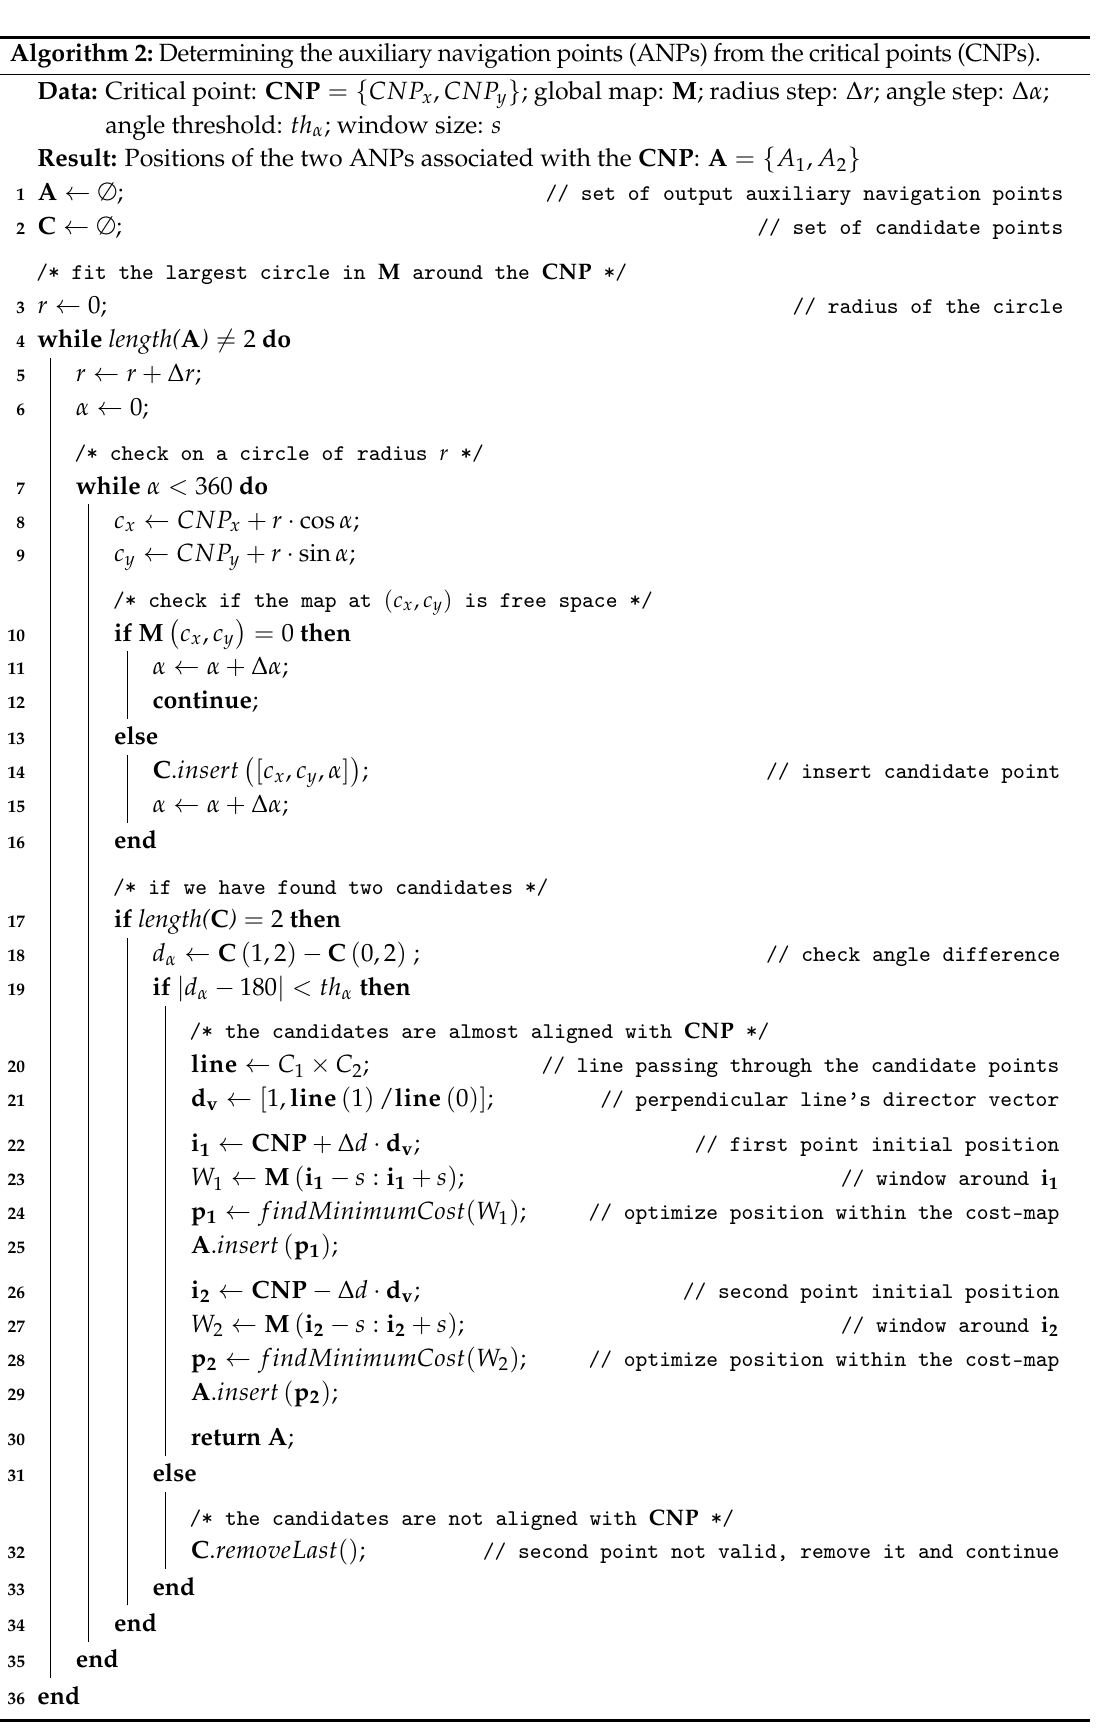
Algorithm 2: Determining the auxiliary navigation points (ANPs) from the critical points